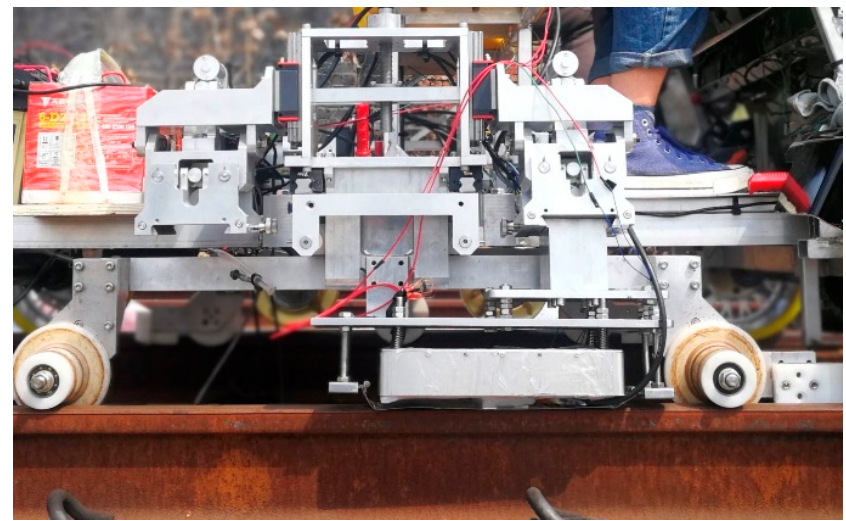
Figure 10. The sliding shoe.